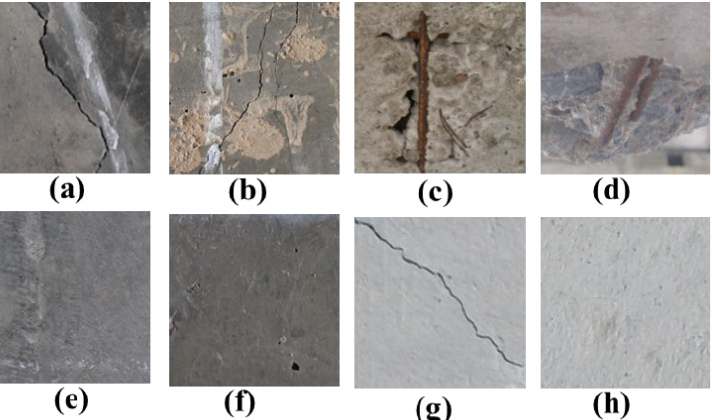
Figure 5. Some representative samples in the dataset. ( a , b ) correspond to the crack in our dataset, ( c , d ) correspond to the area-type damage in our dataset, ( e , f ) correspond to damage-less data, ( g , h ) denotes crack from SDNET 2018 [41].